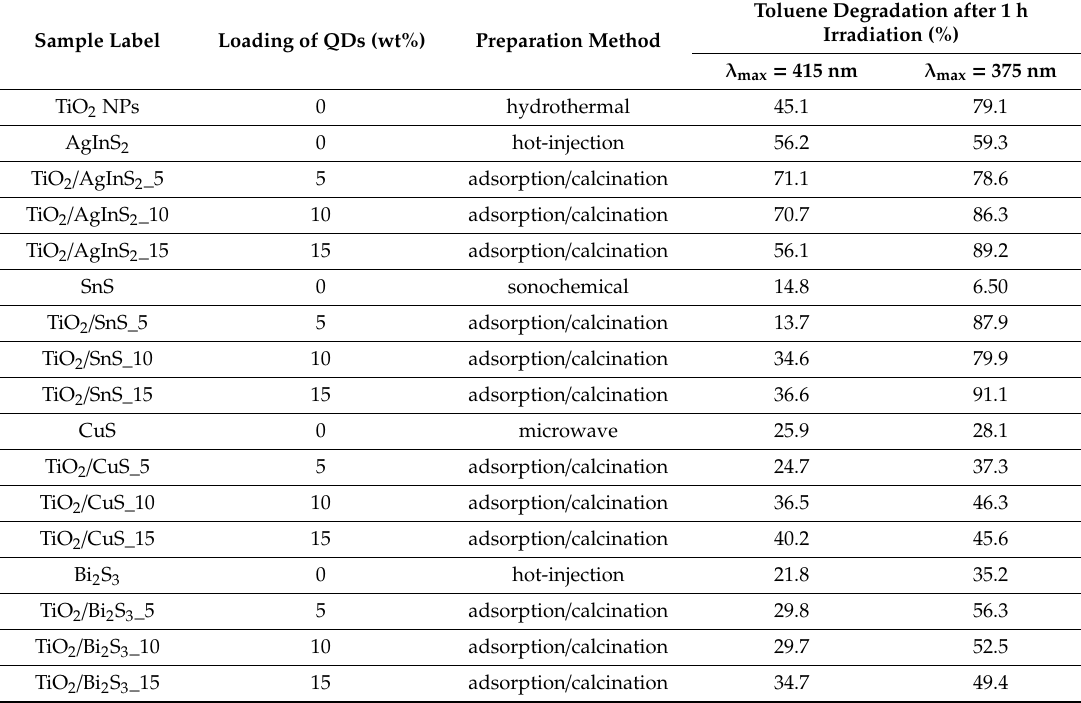
Table 1. Sample label, preparation method and photocatalytic activity of prepared photocatalysts.